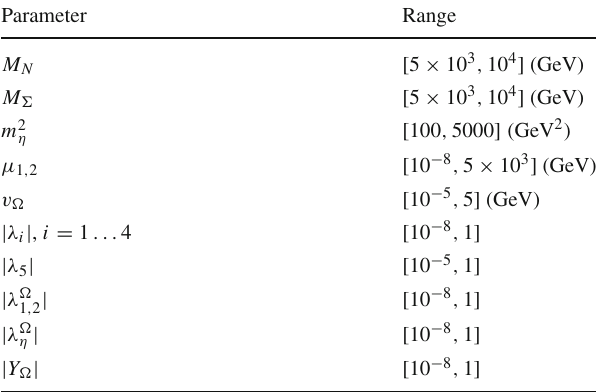
Table 2 Ranges of variation of the input parameters used in the numer- ical scan